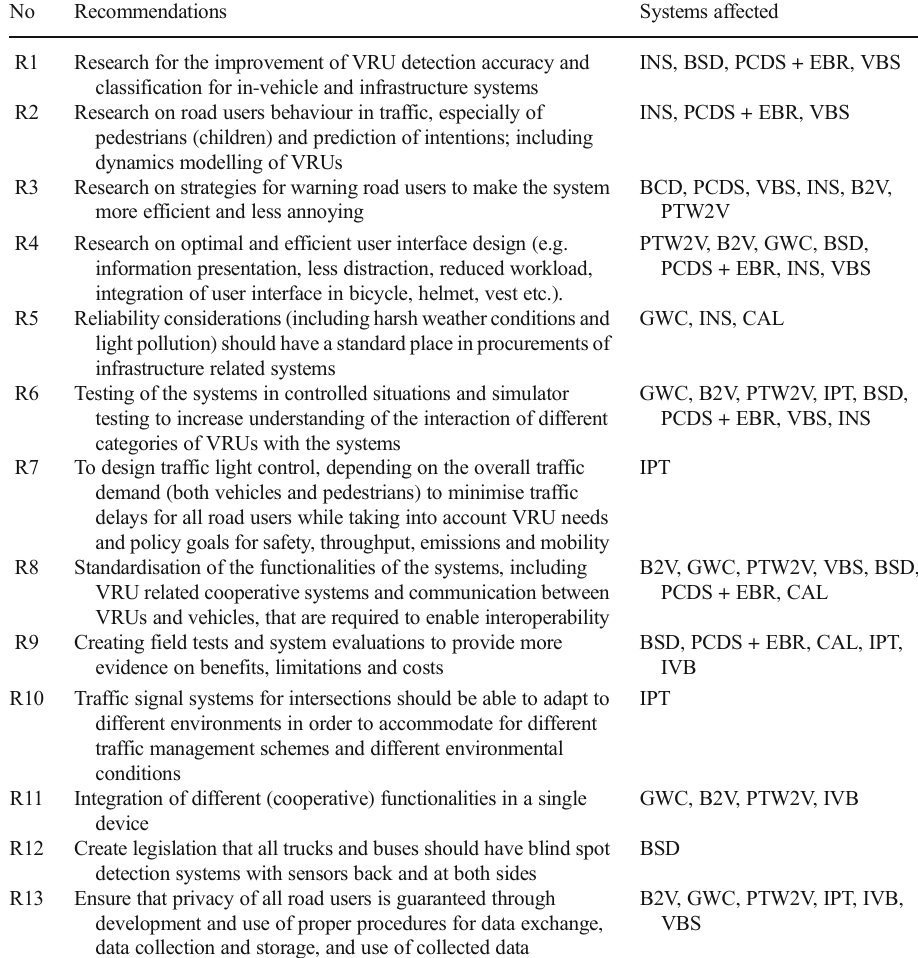
Table 9 Final list of 13 recommendations which were selected for Benefit Analysis (with new numbers)